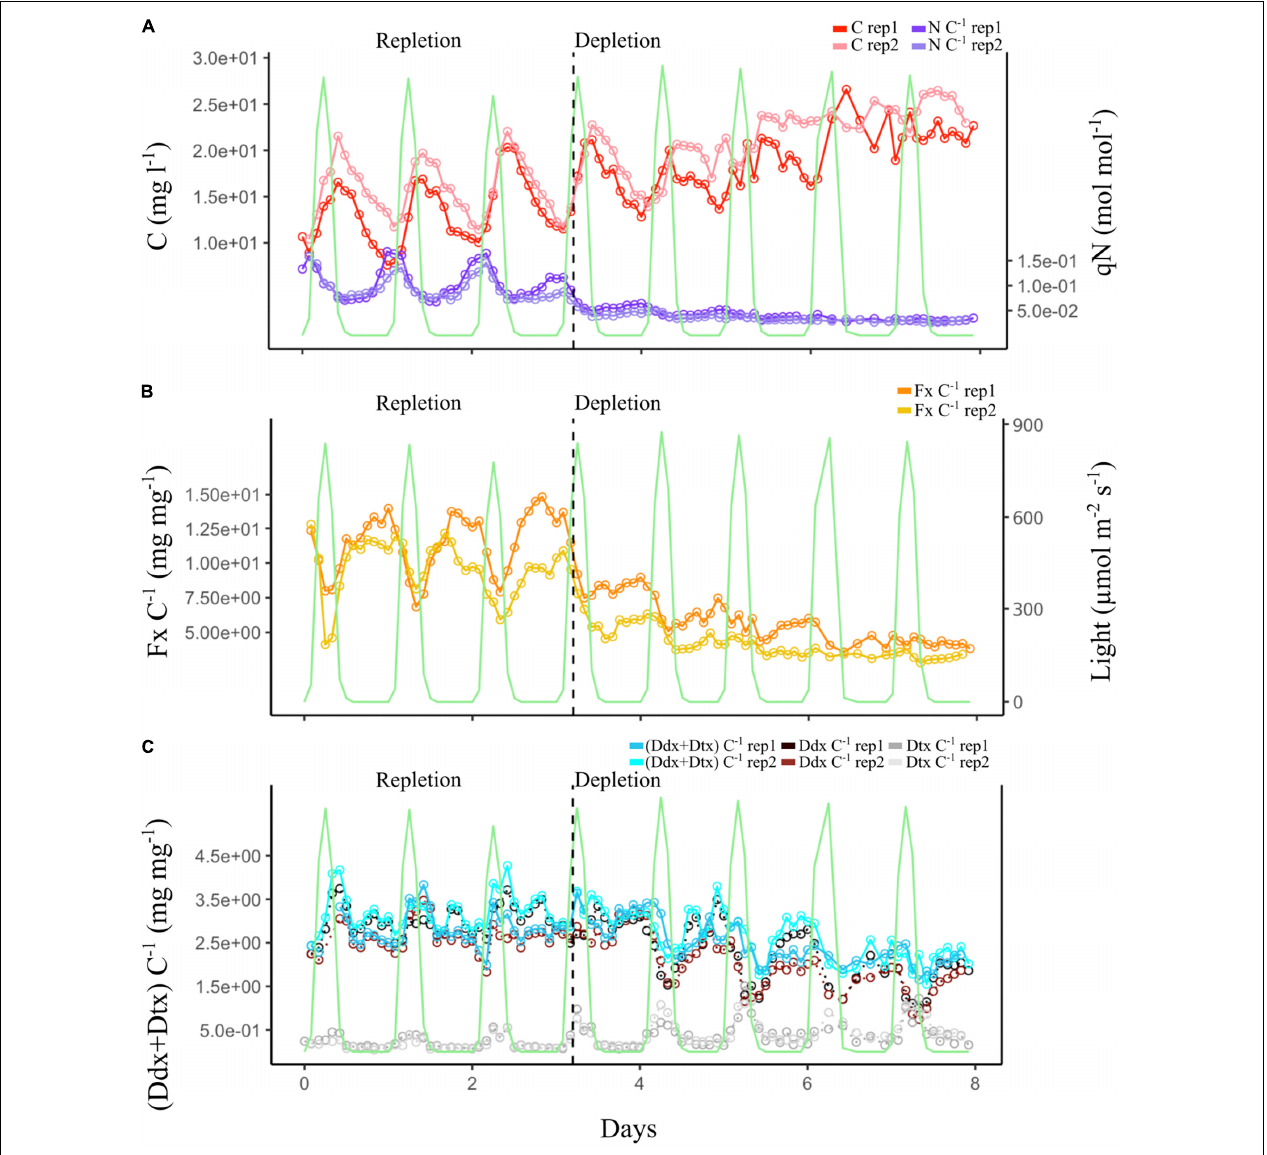
FIGURE 6 | Dynamic light (DL) experiment. The green curve represents photosynthetically active radiation (PAR) during the day:night cycle. (A) Evolution of the cell biomass expressed as total intracellular C and of the qN expressed as intracellular N:C ratio of the two culture replicates. (B) Evolution of the Fx:C ratio of the two culture replicates. (C) Evolution of the photoprotective pigment ratios: (Ddx + Dtx):C, Ddx:C, and Dtx:C of the two culture replicates. Vertical black dashed line marks the transition between the repletion and depletion phases in